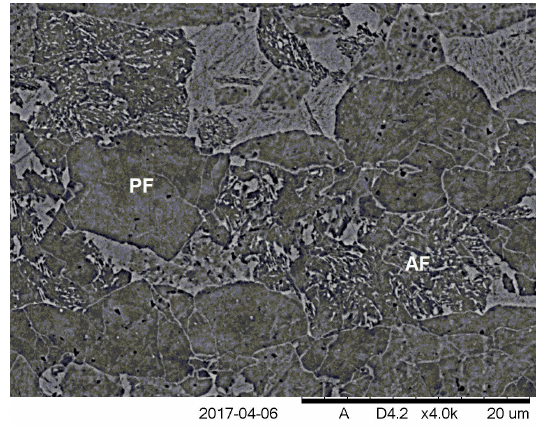
Figure 1. Microstructure showing acicular ferrite (AF) and polygonal ferrite (FP) of X80 steel (magnification